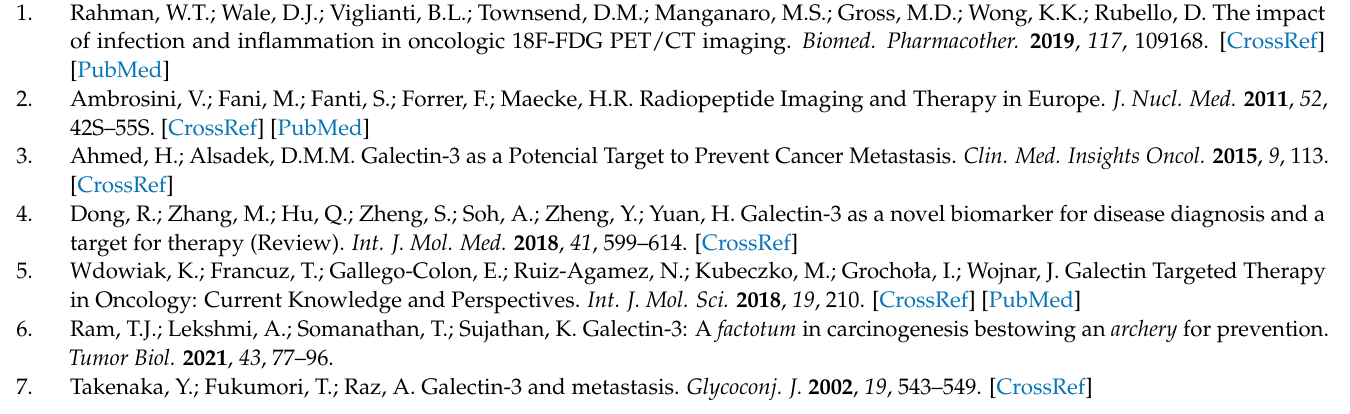
compound 2 , Figure S2: 13 C NMR spectrum of compound 2 , Figure S3: 1 H NMR spectrum of compound 3 , Figure S4: 13 C NMR spectrum of compound 3 , Figure S5: 1 H NMR spectrum of compound 4 , Figure S6: Mass spectrum of compound 2 , Figure S7: Mass spectrum of compound 3 , Figure S8: Mass spectrum of compound 4 , Figure S9: Mass spectrum of compound 7 , Figure S10: Mass spectrum of compound 8 , Figure S11: Mass spectrum of compound 9 , Figure S12: Stability test of [ 68 Ga]Ga-DOTAGA-LacN(NAP) in 0.01 M Na2EDTA solution, Figure S13: Stability test of [ 68 Ga]Ga-DOTAGA-LacN(NAP) in 0.01 M oxalic acid solution, Figure S14: Stability test of [ 68 Ga]Ga- DOTAGA-LacN(NAP)-cRGDfK in 0.01 M Na2EDTA solution, Figure S15: Stability test of [ 68 Ga]Ga- DOTAGA-LacN(NAP)-cRGDfK in 0.01 M oxalic acid solution, Figure S16: Radio-TLC chromatogram of [ 68 Ga]GaCl 3 solution, Figure S17: Stability test of [ 68 Ga]Ga-DOTAGA-LacN(NAP) in human serum after 2 h, Figure S18: Stability test of [ 68 Ga]Ga-DOTAGA-LacN(NAP)-cRGDfK) in human serum after 2 h, Table S1: Ex vivo biodistribution data of 68 Ga-labeled DOTAGA-LacN(NAP), DOTAGA- LacN(NAP)-cRGDfK, and